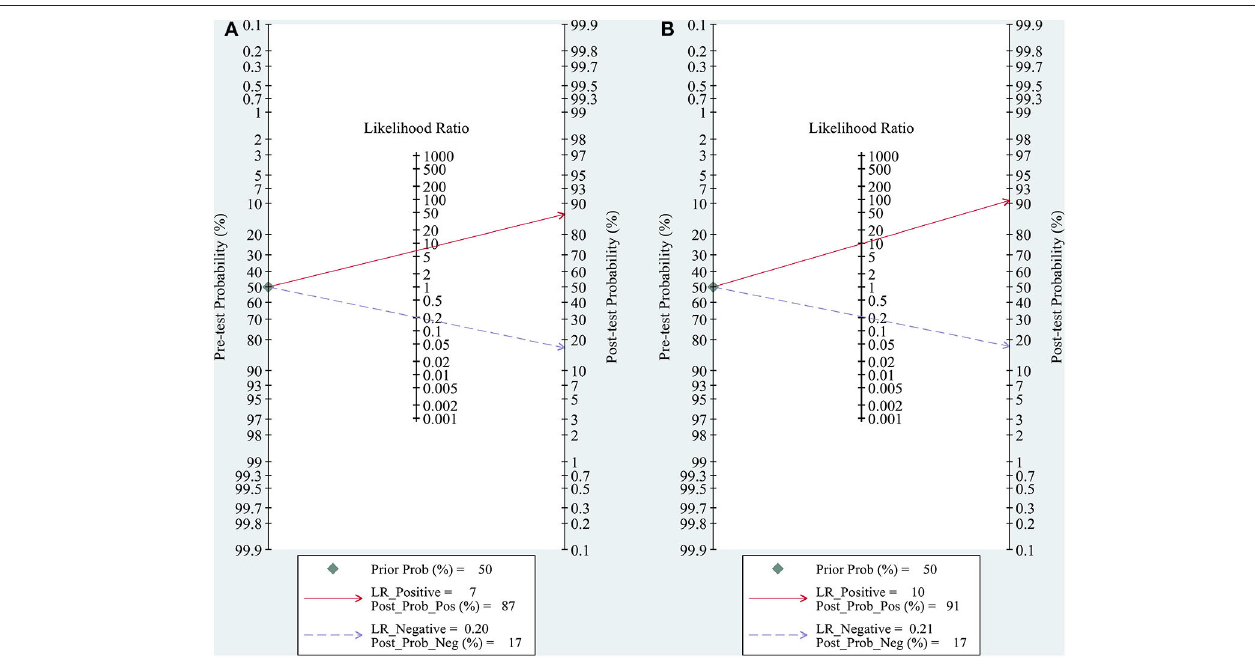
FIGURE 5 | Fagan plots for assessing the clinical utility of quantitative (A) and qualitative (B) elastography to diagnose axillary lymph node metastasis (ALNM) in breast cancer. Fagan plot provided the post-test probability ( P post ) of ALNM when pre-test probabilities ( P pre , suspicion of ALNM) were provided. P post was calculated from the likelihood ratio (LR) using Bayes’s theorem, with P post = (LR × P pre )/[(1 – P pre ) × (1 – LR)]. In this meta-analysis, a P pre of 50% was provided to determine the corresponding P post of